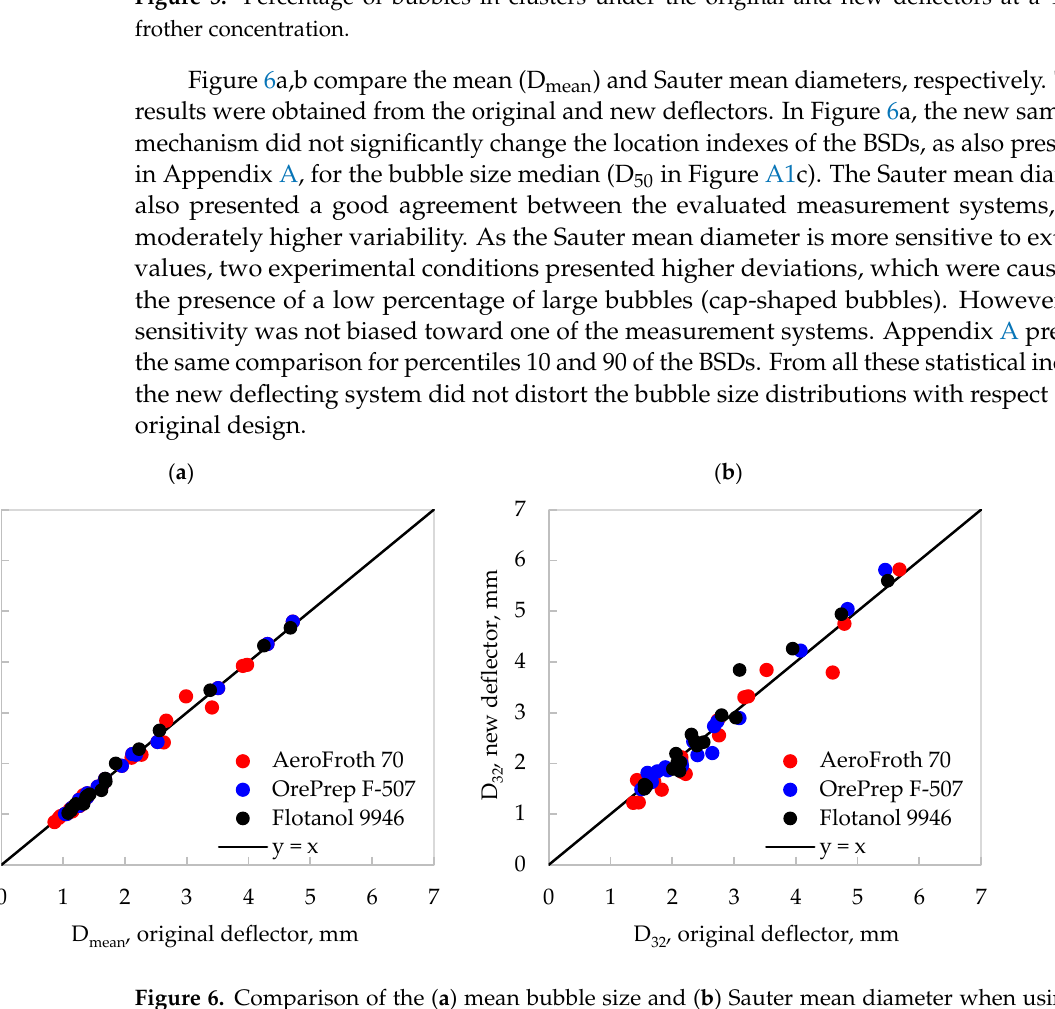
Figure 6. Comparison of the ( a ) mean bubble size and ( b ) Sauter mean diameter when using the original and new deflecting systems, as assessed using the McGill bubble size analyzer.